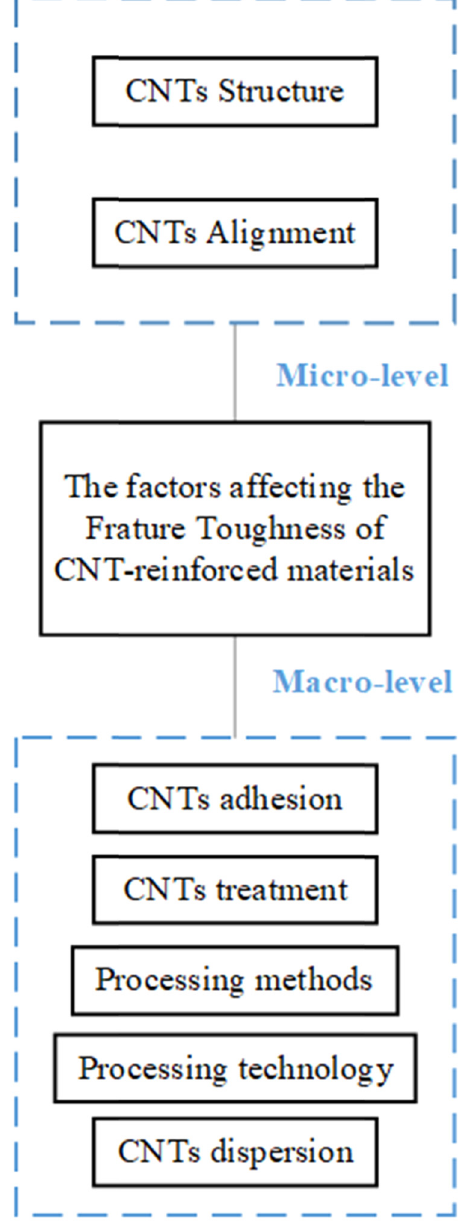
Figure 14: In fl uencing factors of fracture toughness of CNT - enhanced multiscale hybrid